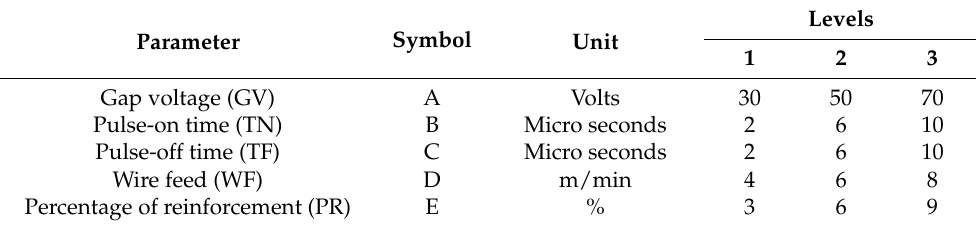
Table 5. Levels of the machining process control parameters.